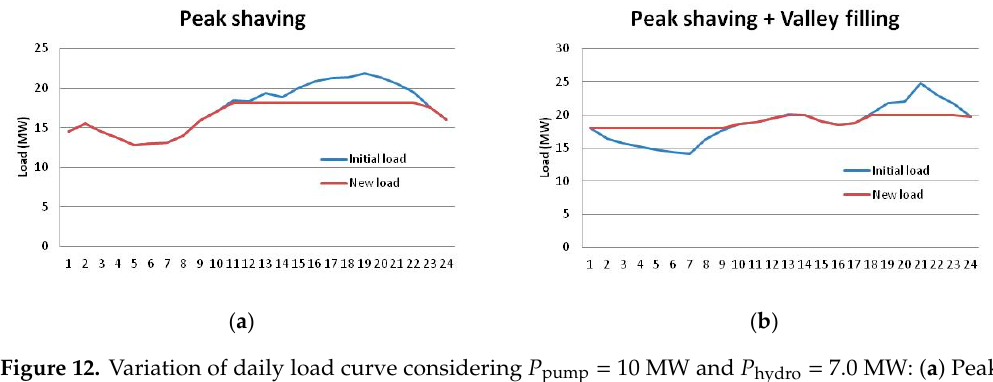
Figure 12. Variation of daily load curve considering P pump = 10 MW and P hydro = 7.0 MW: ( a ) Peak shaving operation of hybrid power station (day 4 of the year); ( b ) peak shaving and valley filling operation of hybrid power station (day 206 of the year).